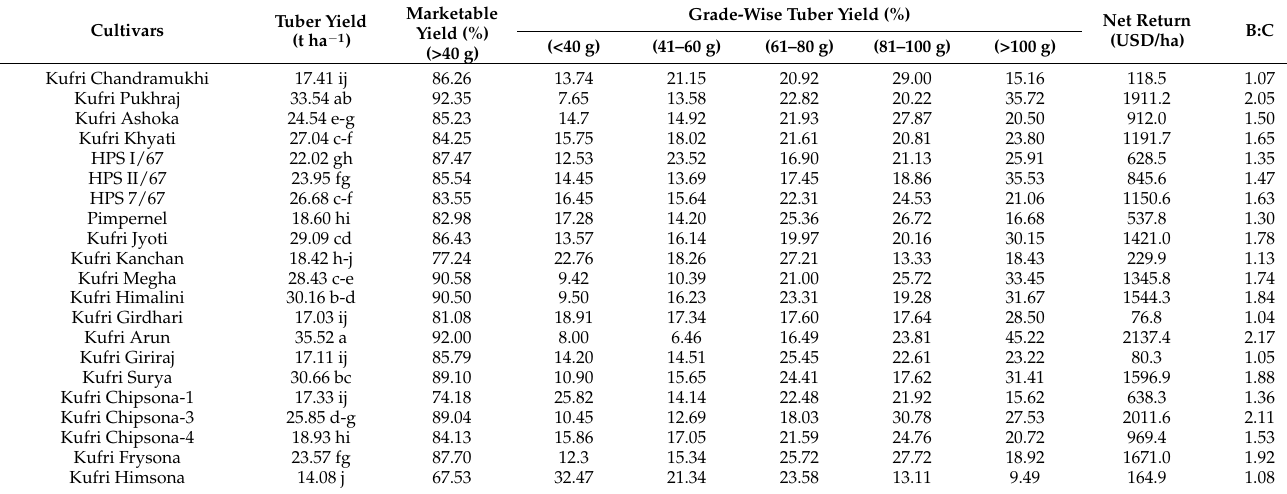
Table 4. Yield and production economics of various potato cultivars (estimation from two years’ pooled data). Cultivars